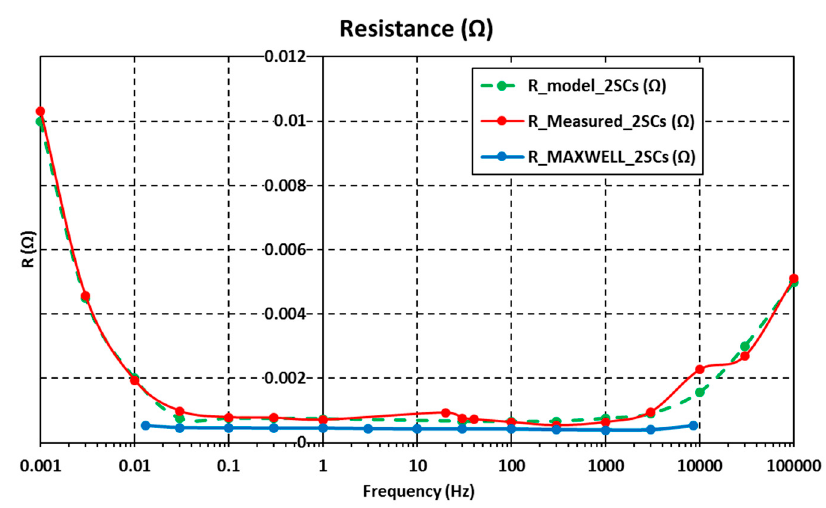
Figure 15. Comparison in the frequency response of the measured resistance from the experimental tests (red line) and the equivalent resistance value from the electrical circuit model of the SCs (green line). The resistance value provided by the manufactured is also plotted in blue.